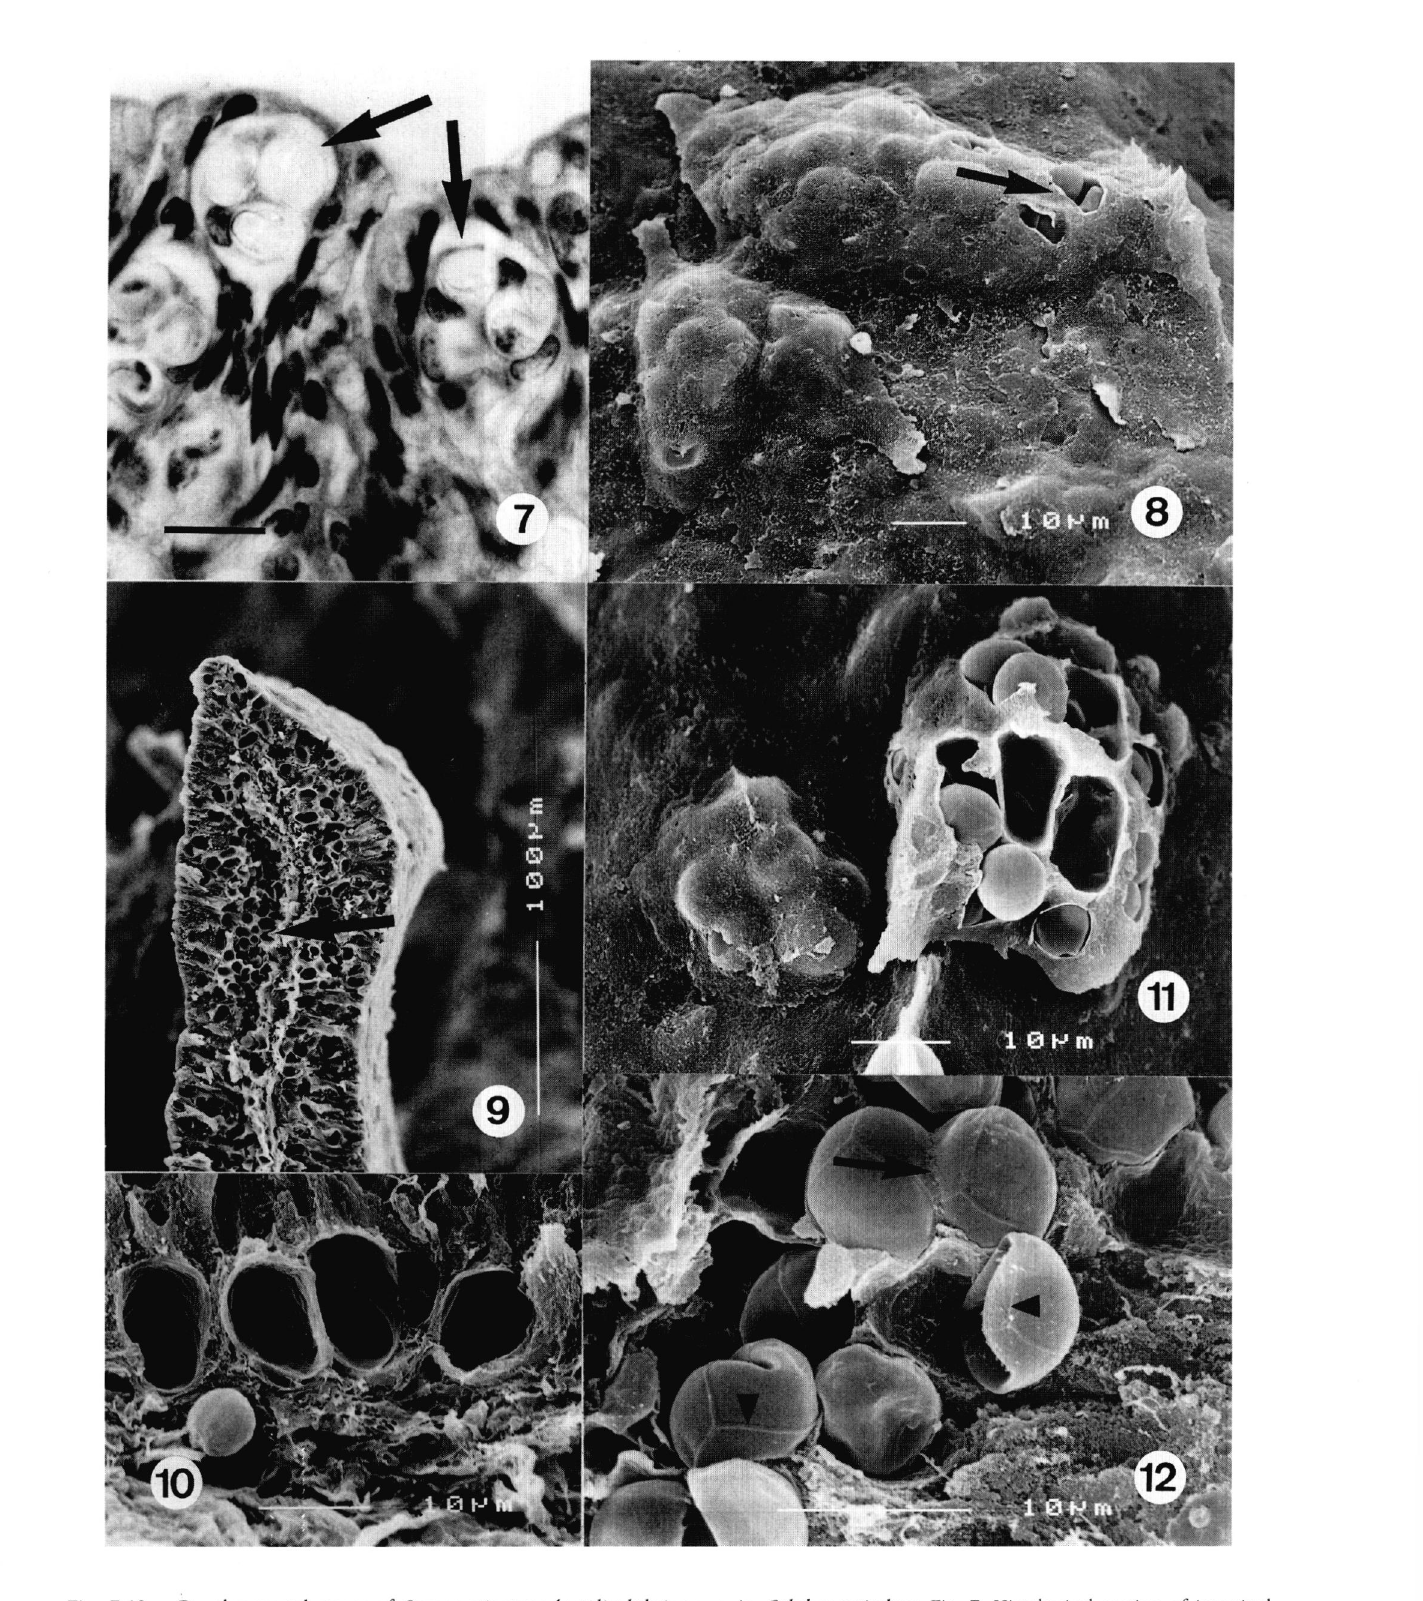
Figs 7-12. - Developmental stages of Sarcocystis stenodactylicolubris sp. n. in Coluber najadum. Fig. 7. Histological section of intestinal mucosa with oocysts/sporocysts (arrows), scale bar = 10 pm. Fig. 8. SEM picture of mucosal surface showing erosions with liberating spo­ rocysts (arrow). Fig. 9. SEM picture of cross section through intestinal mucosa with numerous hollows indicating previous location of deve­ lopmental stages (arrow). Fig. 10. Detail view of the same region. Fig. 11. Sporocysts liberating in clusters from erosions in the mucosal surface. Fig. 12. Oocyst (arrow) and sporocysts liberated from the intestinal mucosa. Note rib-like prominating sutures of plates of sporo­ cyst wall (arrowheads). Parasite, 2000, 7, 201-207 Mémoire